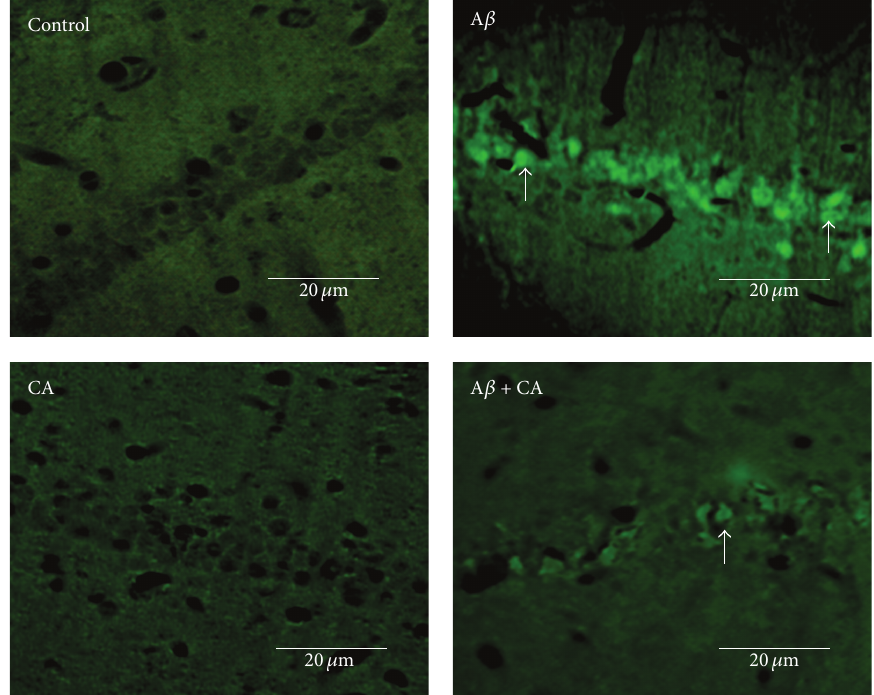
Figure 3: Fluoro-jade b staining in the Ca1 area of the hippocampus in the experimental groups (control, CA: carnosic acid, A 𝛽 : Amyloid beta, and A 𝛽 + CA: carnosic acid + A 𝛽 ). The white arrows show the fluorescent positive neurons in the Ca1 region of the hippocampus (400x).